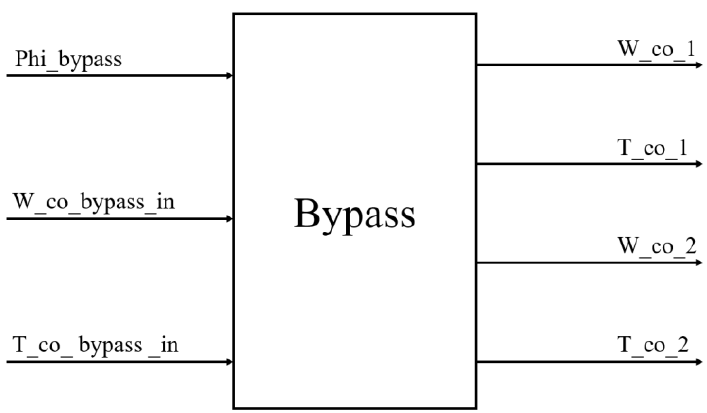
Figure 11. The input and output of the bypass model.